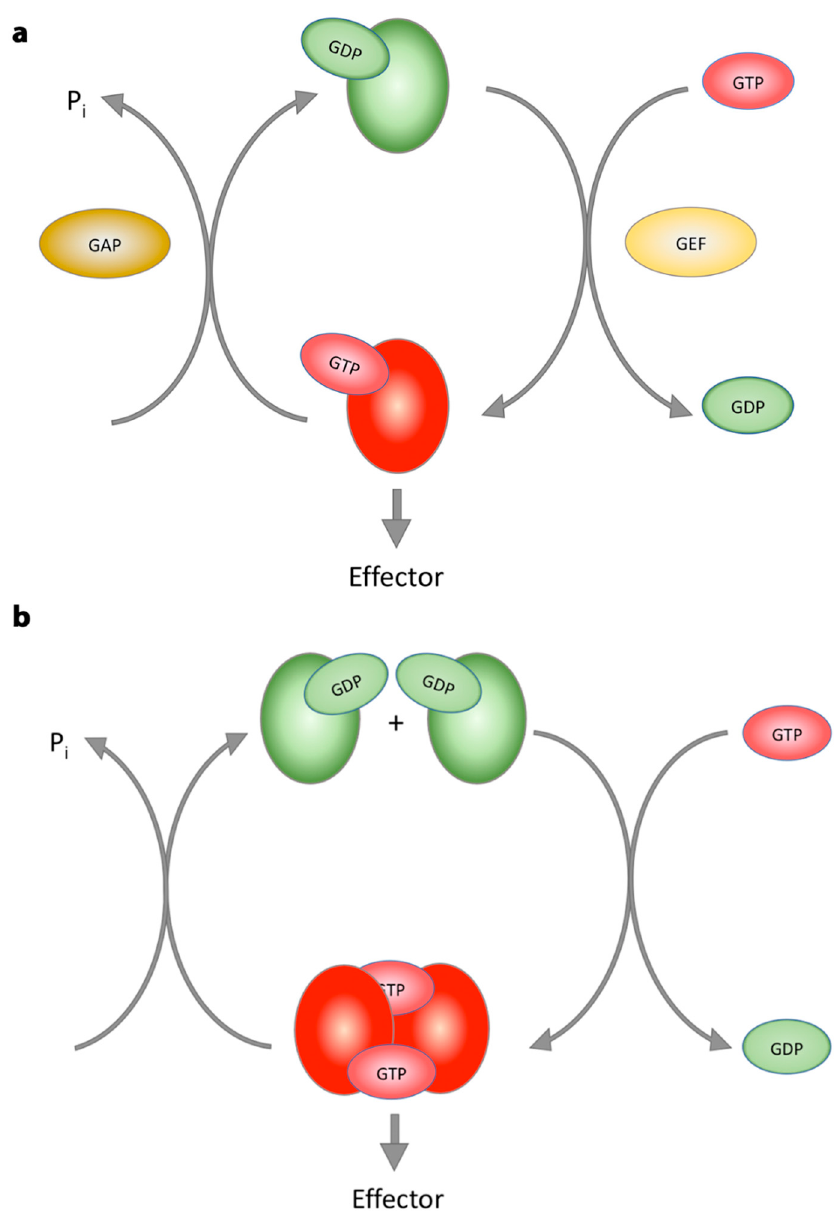
Figure 4. G-protein cycle of conventional G-proteins versus G-proteins activated by dimerization (GADs). ( a ) Conventional G-proteins have very high nucleotide affinities resulting in a low nucleotide dissociation rate. Binding of guanine nucleotide exchange factors (GEFs) decreases the affinity for the bound nucleotide allowing it to be released from the protein. Due to the higher cellular GTP concentration, GTP then binds to the protein and the protein switches to its active GTP-bound state, where it interacts with downstream effectors. GTPase activating proteins (GAPs) can then bind to the G-protein, stabilize and/or complement its catalytic machinery and in this way, increase its intrinsically low GTP hydrolysis rate. The G-protein then switches to its GDP-bound inactive state. ( b ) GADs have micromolar nucleotide affinities, leading to high nucleotide dissociation rates. Therefore, they do not require GEFs to cycle from their inactive GDP- to their active GTP-bound state. Following GTP binding, the G-domains of GADs dimerize. In this way, both subunits complement each other’s active site and are able to hydrolyse GTP. The GADs then cycle back to their inactive, GDP-bound state. In conclusion, GADs possess all the necessary components for GTP-binding and hydrolysis and cycle between an active and inactive state without the aid of GEFs and GAPs [108].